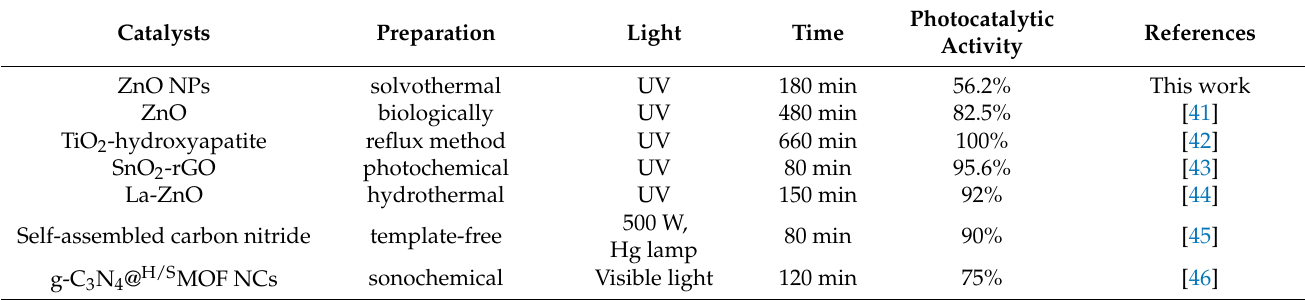
Table 4. Summary of the degradation of PNP with different